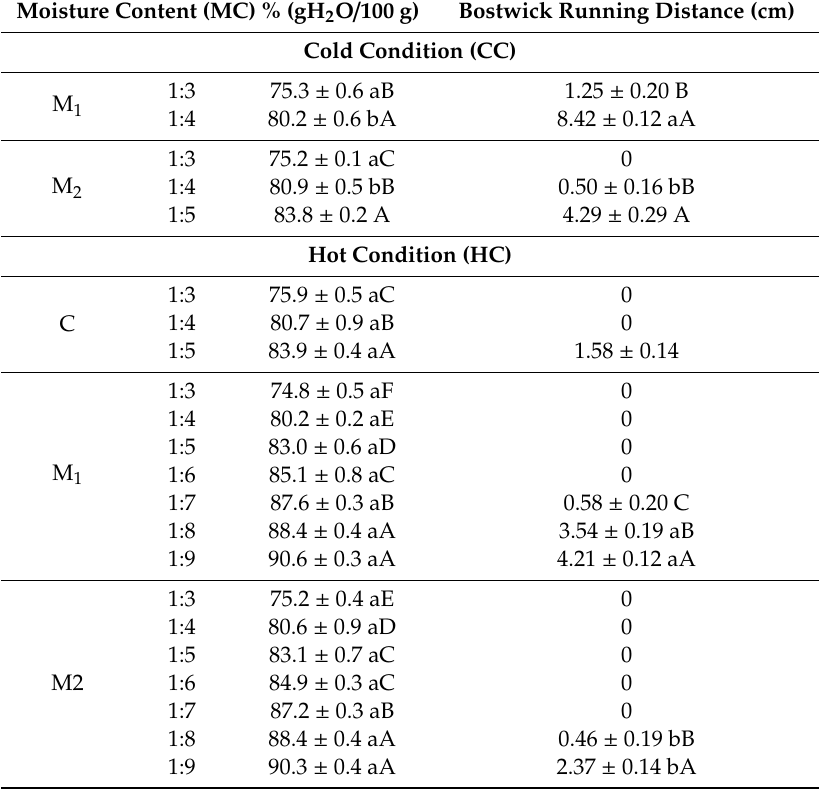
Table 3. Moisture content (MC) and Bostwick running distances of corn flour-water systems prepared with three corn flours (C, M 1 and M 2 ) at di ff erent flour:water ratio (1:3, 1:4, 1:5, 1:6, 1:7, 1:8 and 1:9) in cold (CC) and hot conditions